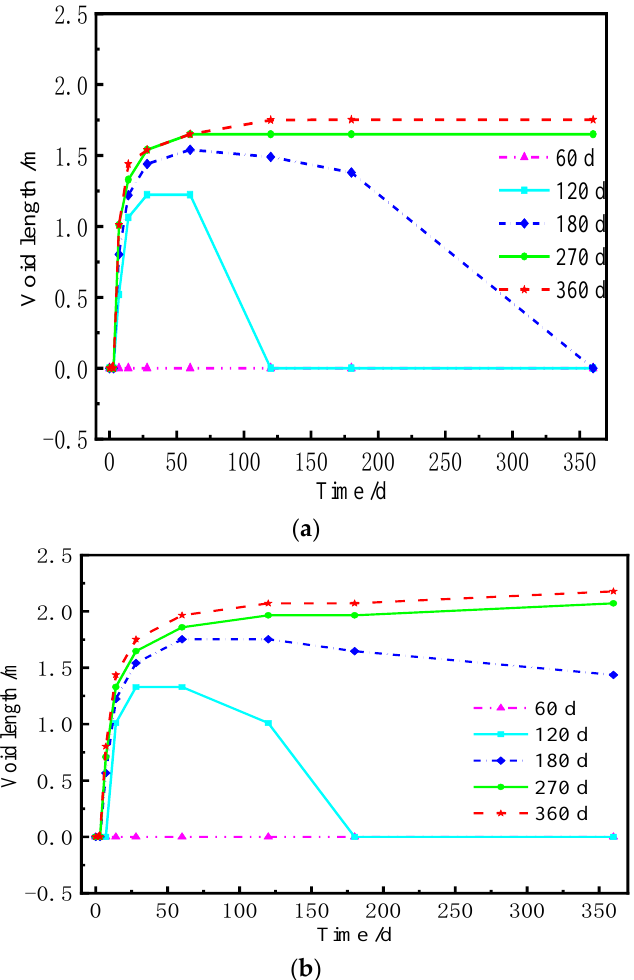
Figure 18. Gap length of the sliding layer at the middle of the slab. ( a ) With the shear cogging. ( b ) Without the shear cogging.